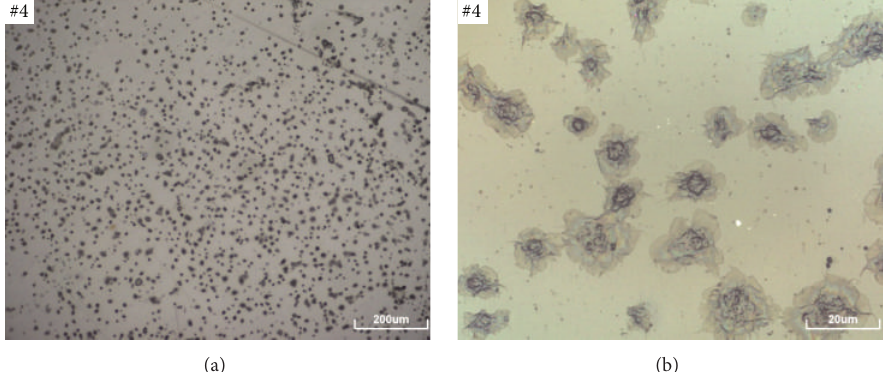
Figure 6: Optical image of platelets on surface of PET polymer treated in nitrogen plasma (#4) after incubation with fresh blood at two different magnifications ((a) and